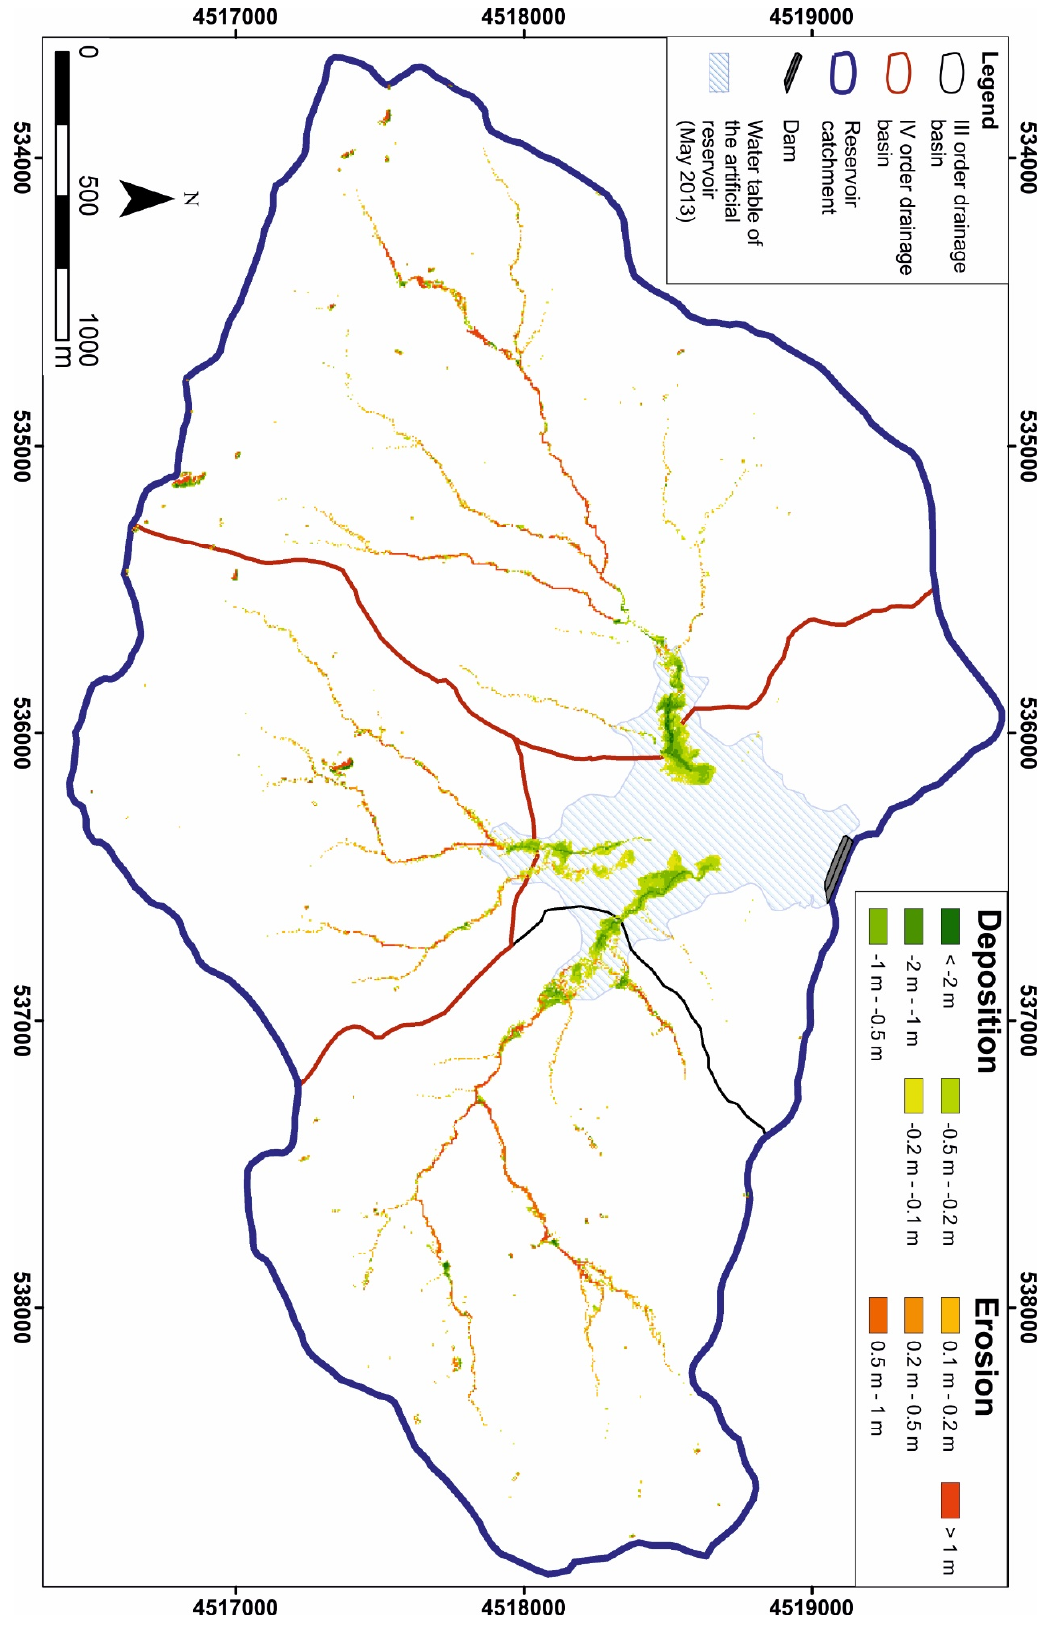
Figure 7. Elevation di ff erence map deriving by the Caesar–Lisflood landscape evolution model (LEM).